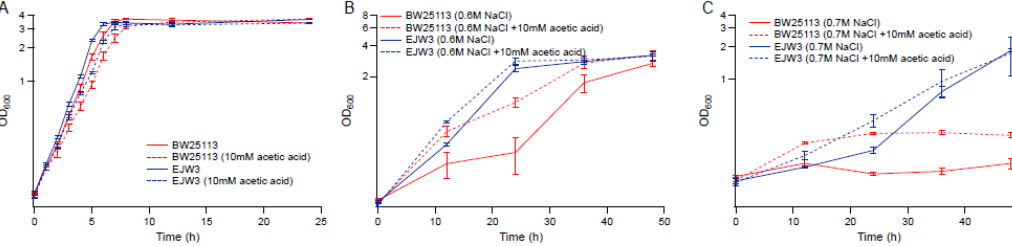
Figure 6. Effect of acetic acid on osmotic tolerance. ( A ) M9 only. ( B ) M9 supplemented with 0.6 M NaCl. ( C ) M9 supplemented with 0.7 M NaCl. Error bars are standard deviations.